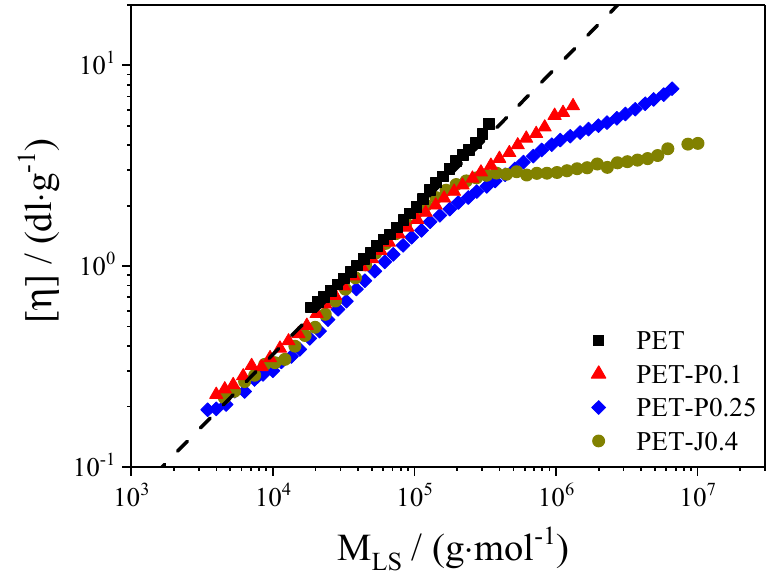
Figure 2. Intrinsic viscosity [ η ] as a function of the absolute molar mass M LS determined by light scattering for PET modified with PMDA or Joncryl [8,9].